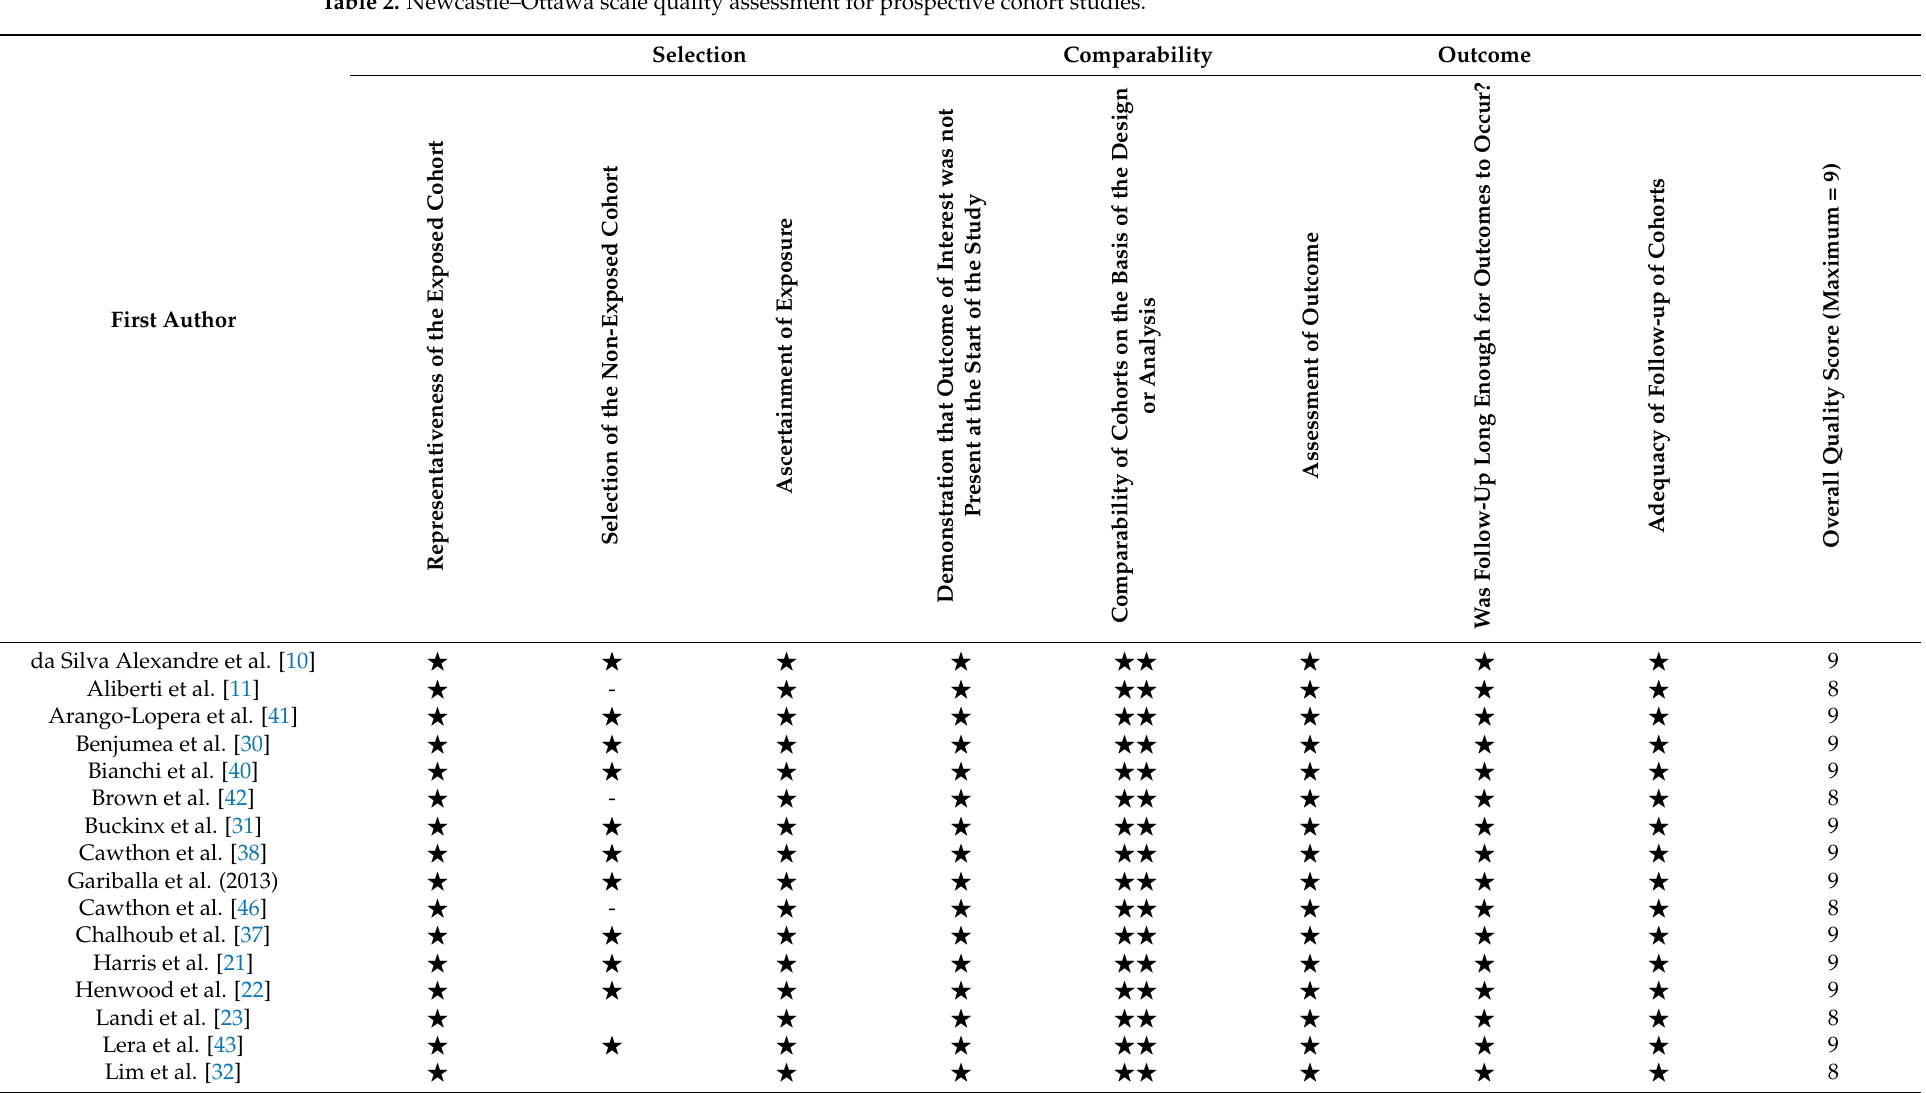
Table 2. Newcastle–Ottawa scale quality assessment for prospective cohort